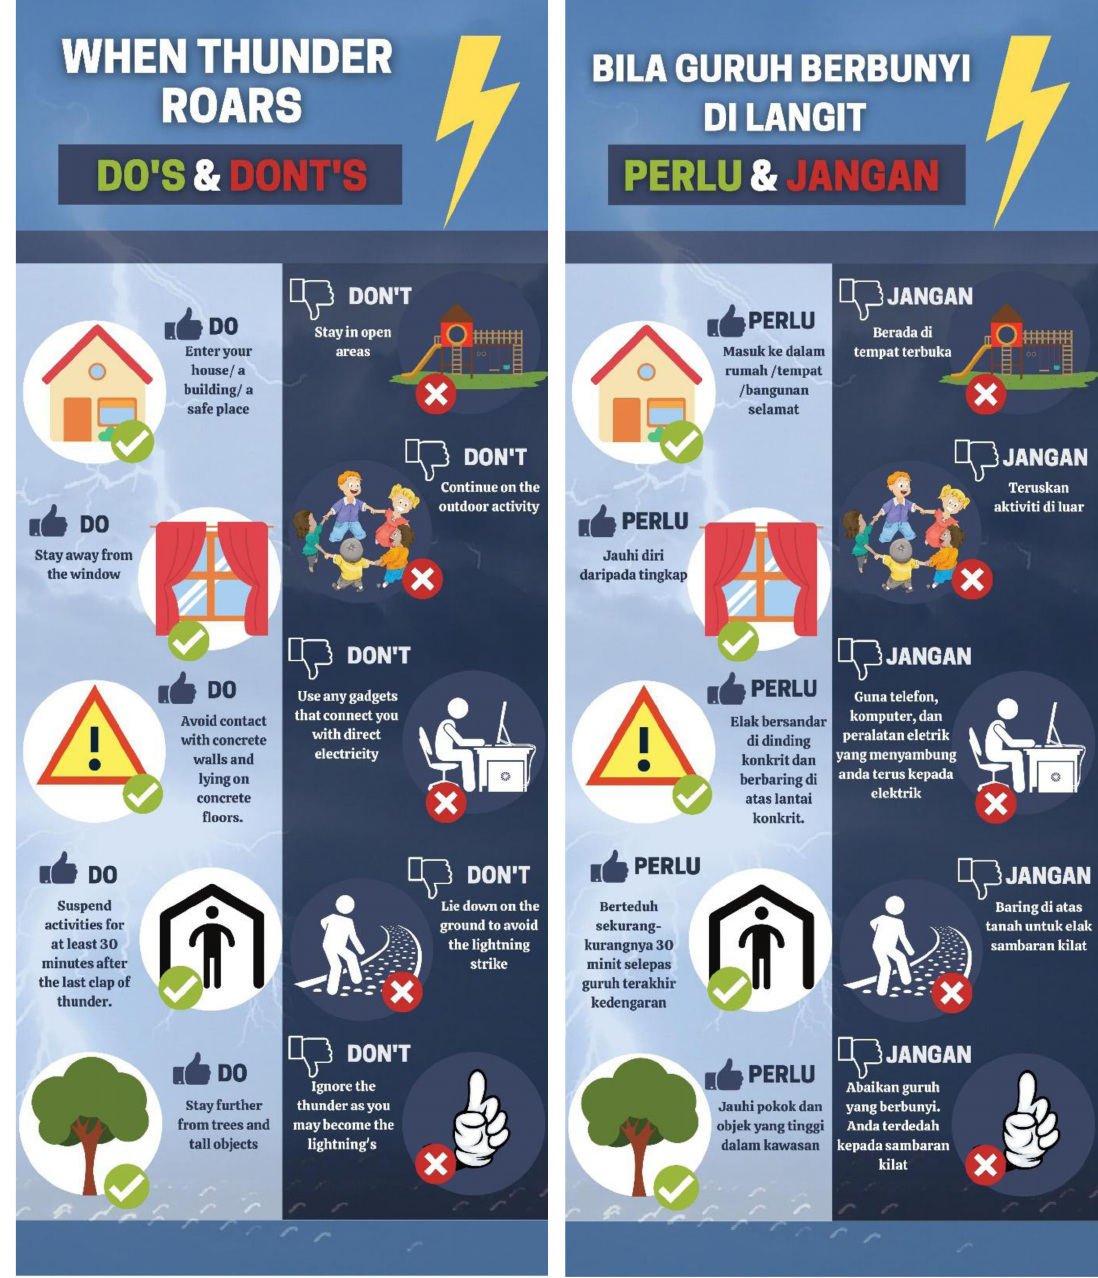
Figure 2. Lightning safety message based on common myths observed (in English and Malay).